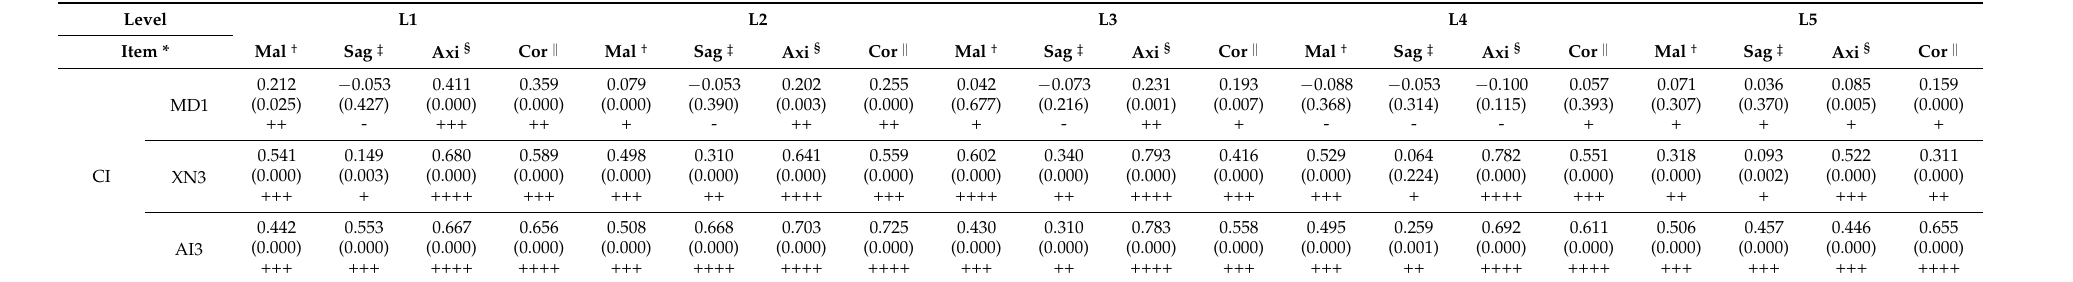
Table 4. Comparison of diagnostic concordance among the gold standard and diagnosis of representative for each diagnostic